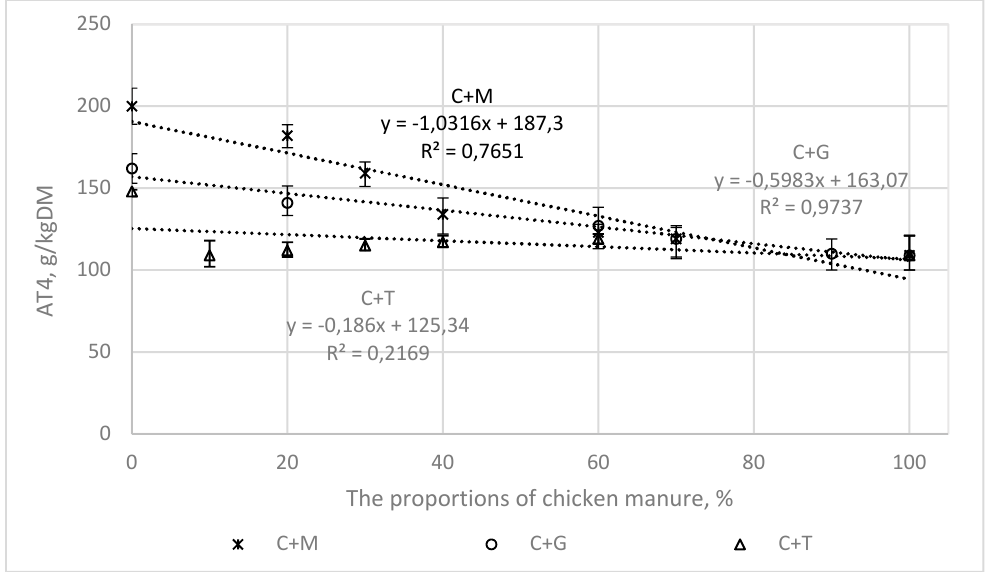
Figure 4. The correlations between AT4 and the proportions of chicken manure in the mixtures with co-substrates .